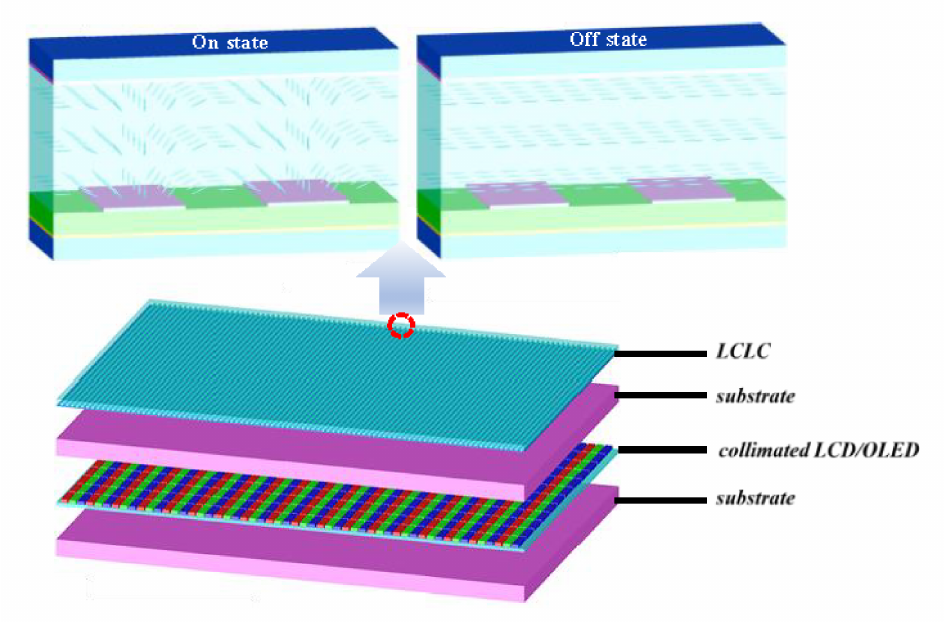
Figure 1. The schematic of a collimated LCD/OLED with the liquid crystal lens-like cell.